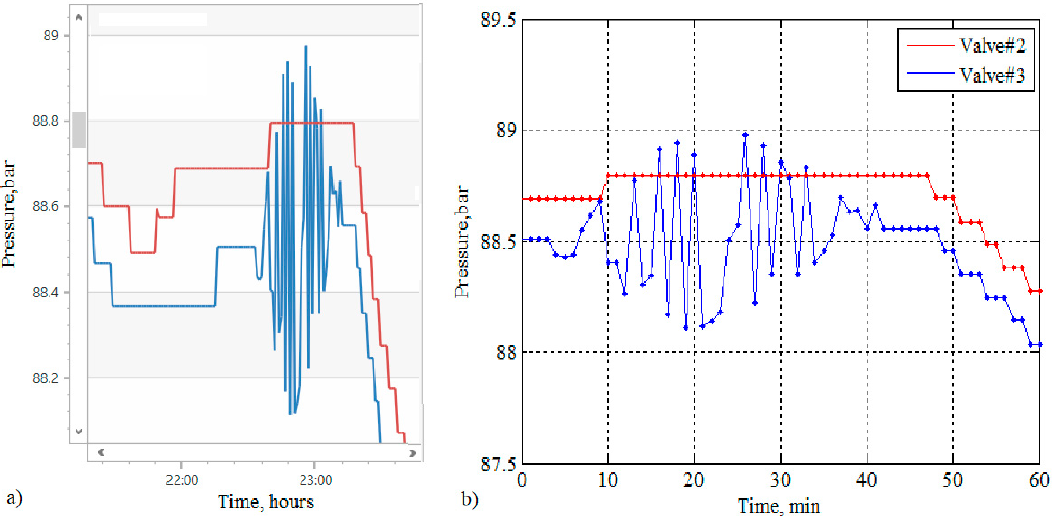
Figure 11. High-frequency fluctuations of regime parameters/chatter. Example 8 (valve 3): ( a ) a general view, ( b ) a detailed view. Table 1. Indicators of the processes of